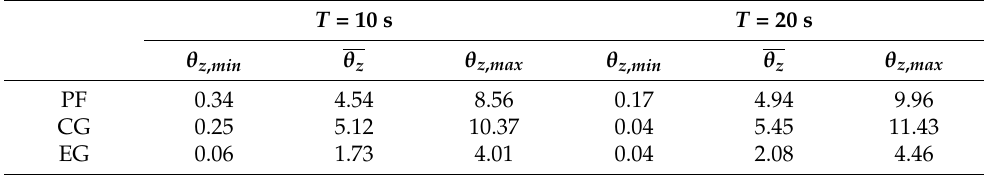
Figure 16. Comparison of balance performance when T = 10 s and T = 20 s in real-world experiments. According to the mean values in Table 4, when T = 10 s, balance efficiencies η PF and η CG reach 61.89% and 66.21%. When T = 20 s, they are 57.89% and 61.83%, respectively. Table 4. Tilt angles θ z in real-world experiments ( ◦